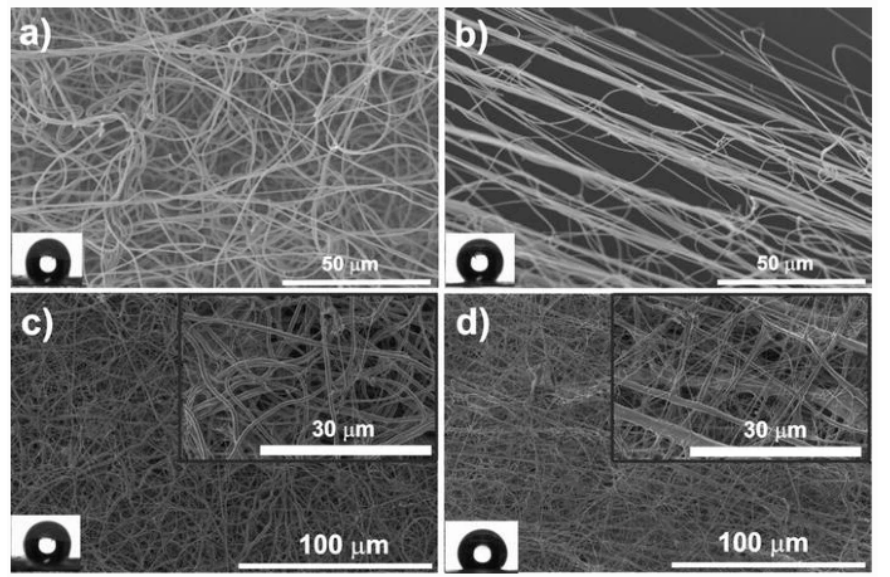
Figure 8. Morphology of electrospun polymer fiber mats: ( a ) randomly oriented neat PVDF, ( b ) aligned neat PVDF fibers, ( c ) randomly oriented PVDF with 5 wt% IL, and ( d ) aligned PVDF fibers with 5 wt% IL [Emim][TFSI] obtained. Reprinted with permission of [117].